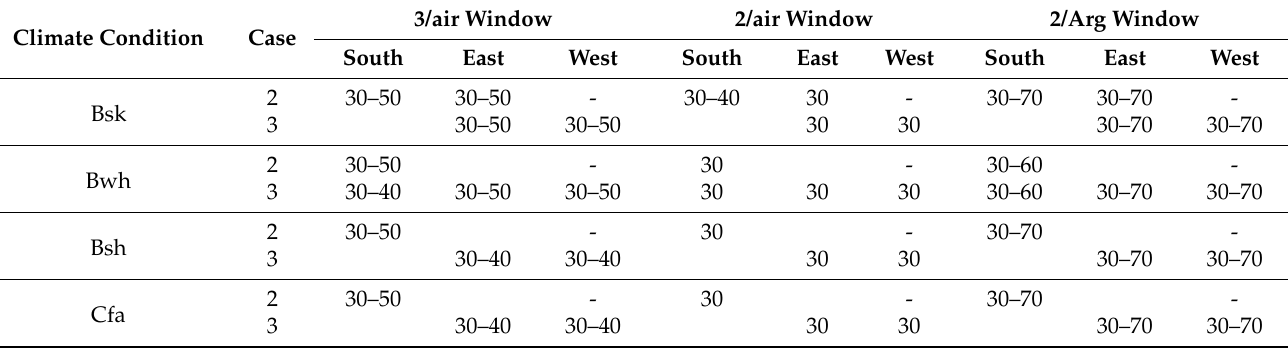
Table 6. Optimal WWR range for the studied cases in the studied climate conditions and orientations in warm climates. Cases 2 and 3 refer to the combination of windows with shade and blinds,